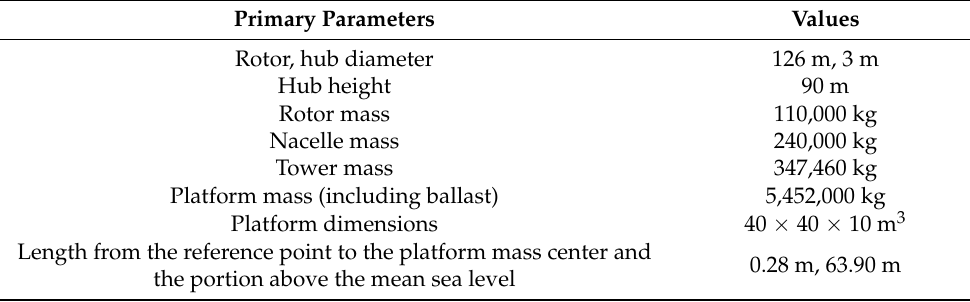
Table 1. Primary parameters of a barge-type wind turbine